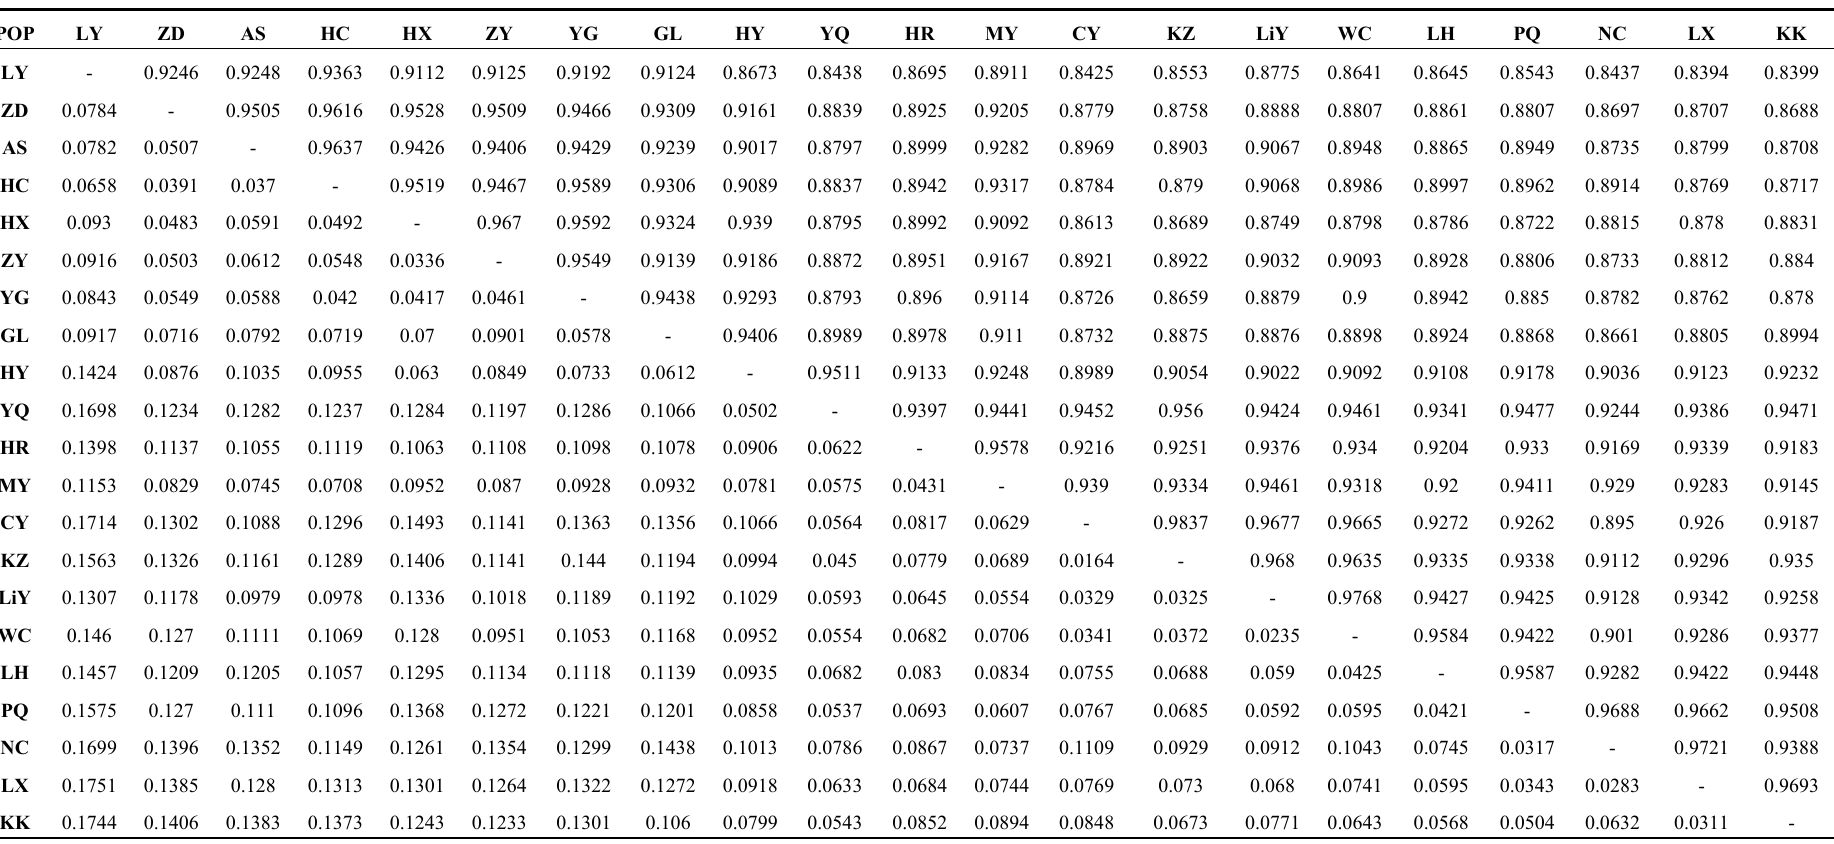
Table S3. Nei’s (1978) unbiased genetic identity (above diagonal) and genetic distance (below diagonal) among Siberia apricot populations reveled by ISSR markers